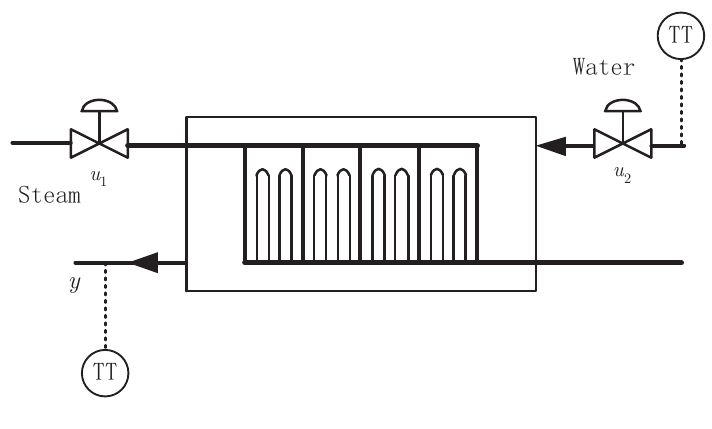
Figure 1. The steam water heat